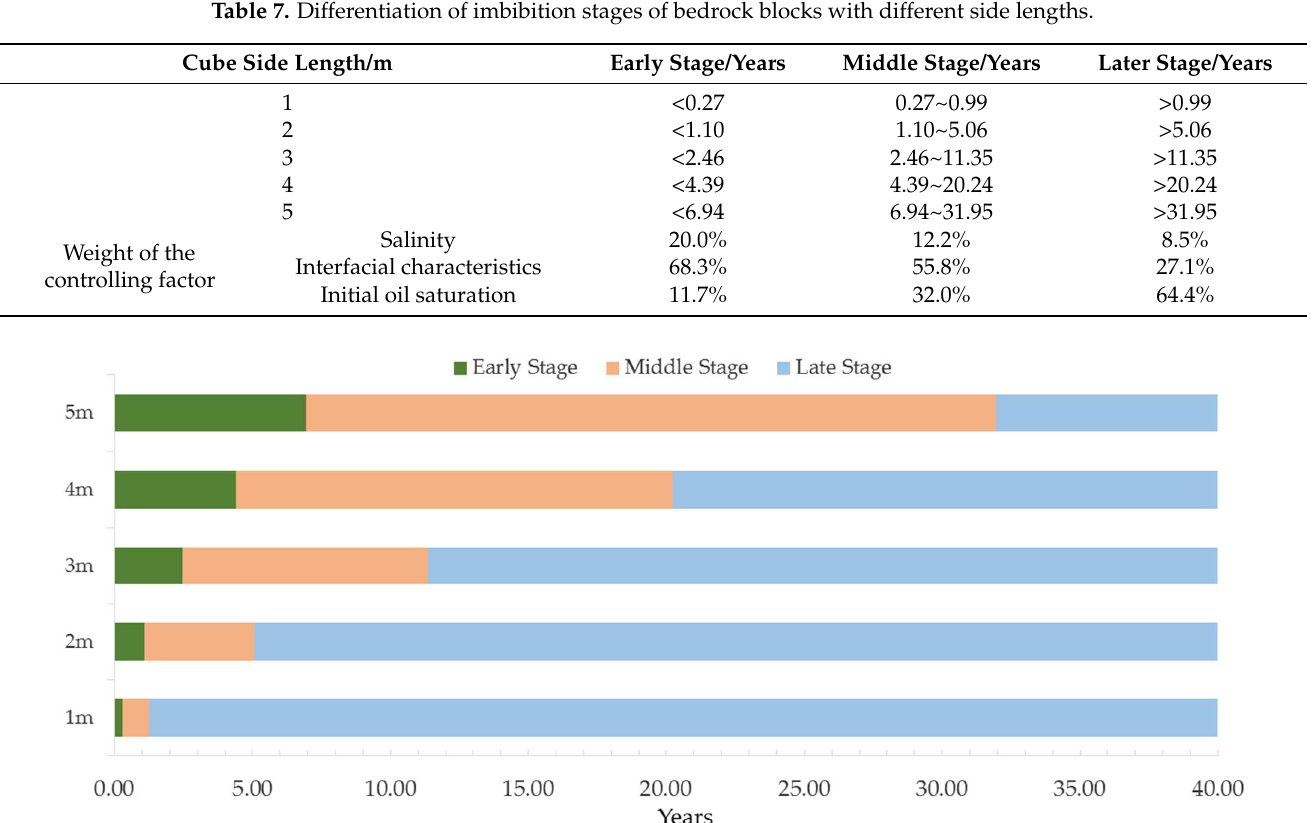
Table 7. Differentiation of imbibition stages of bedrock blocks with different side lengths.